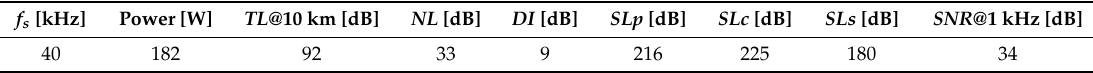
Table 1. Results for the beams at a distance of 10